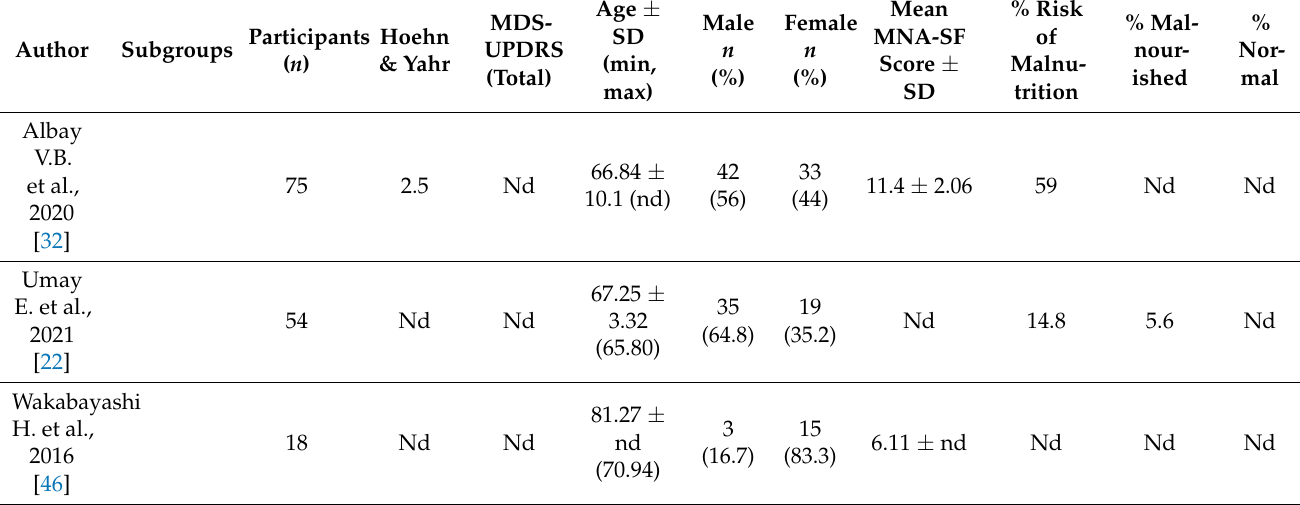
Table 11. MNA-SF